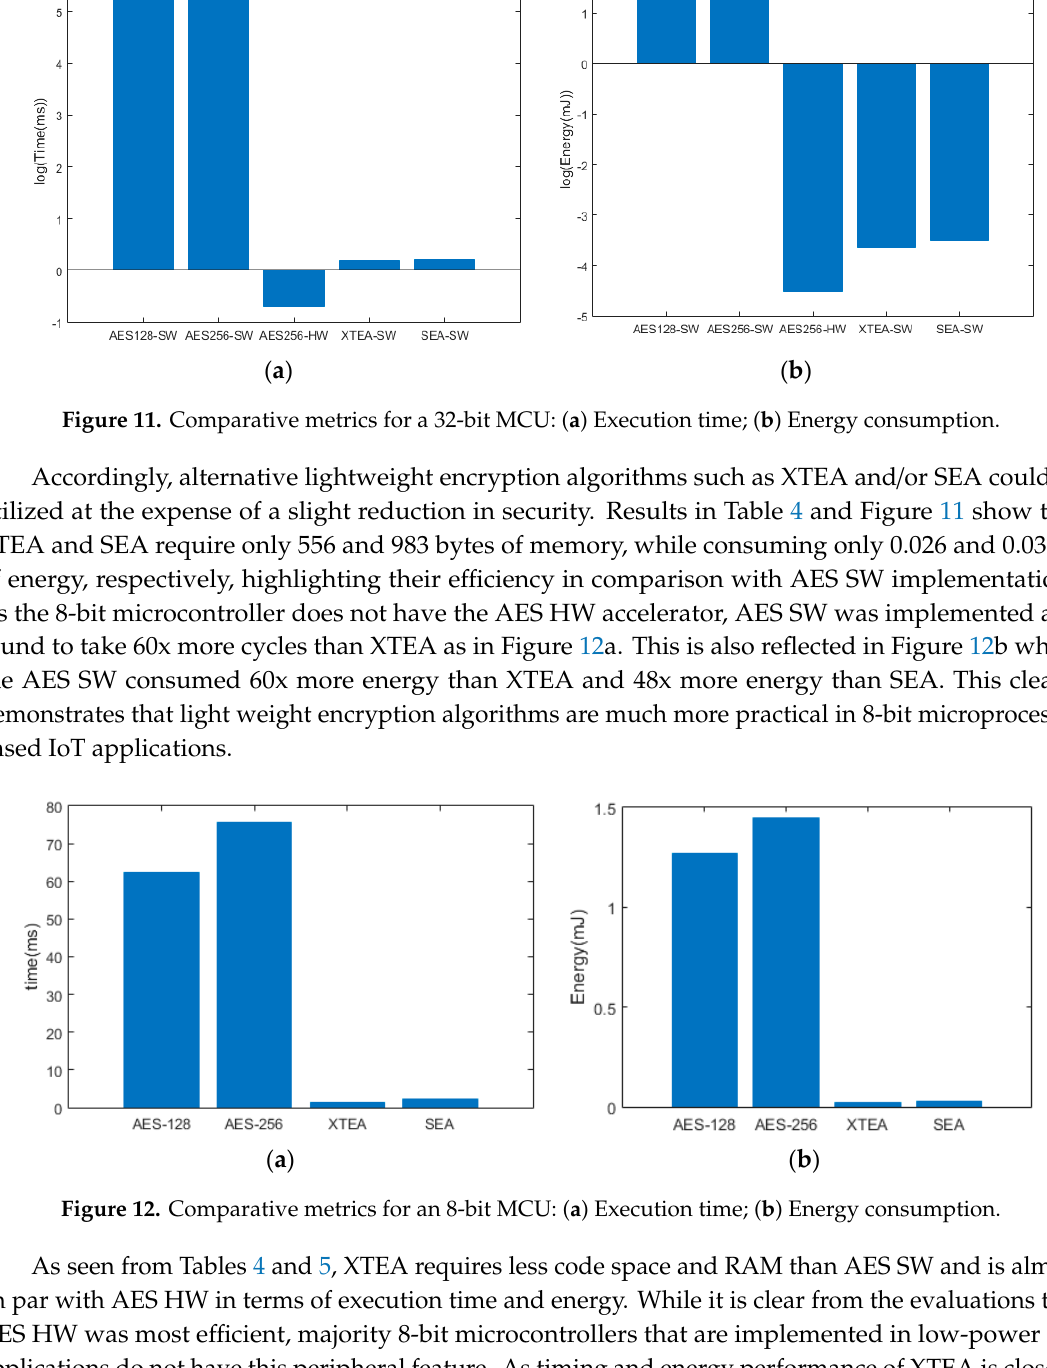
Figure 12. Comparative metrics for an 8-bit MCU: ( a ) Execution time; ( b ) Energy consumption.